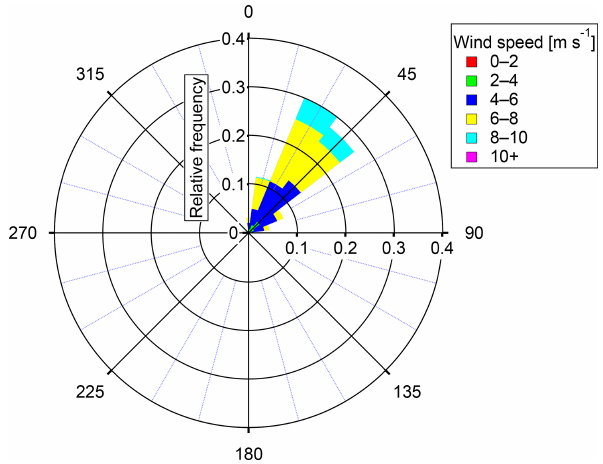
Figure 2. Wind rose based on hourly averages of wind speed and direction (measured at